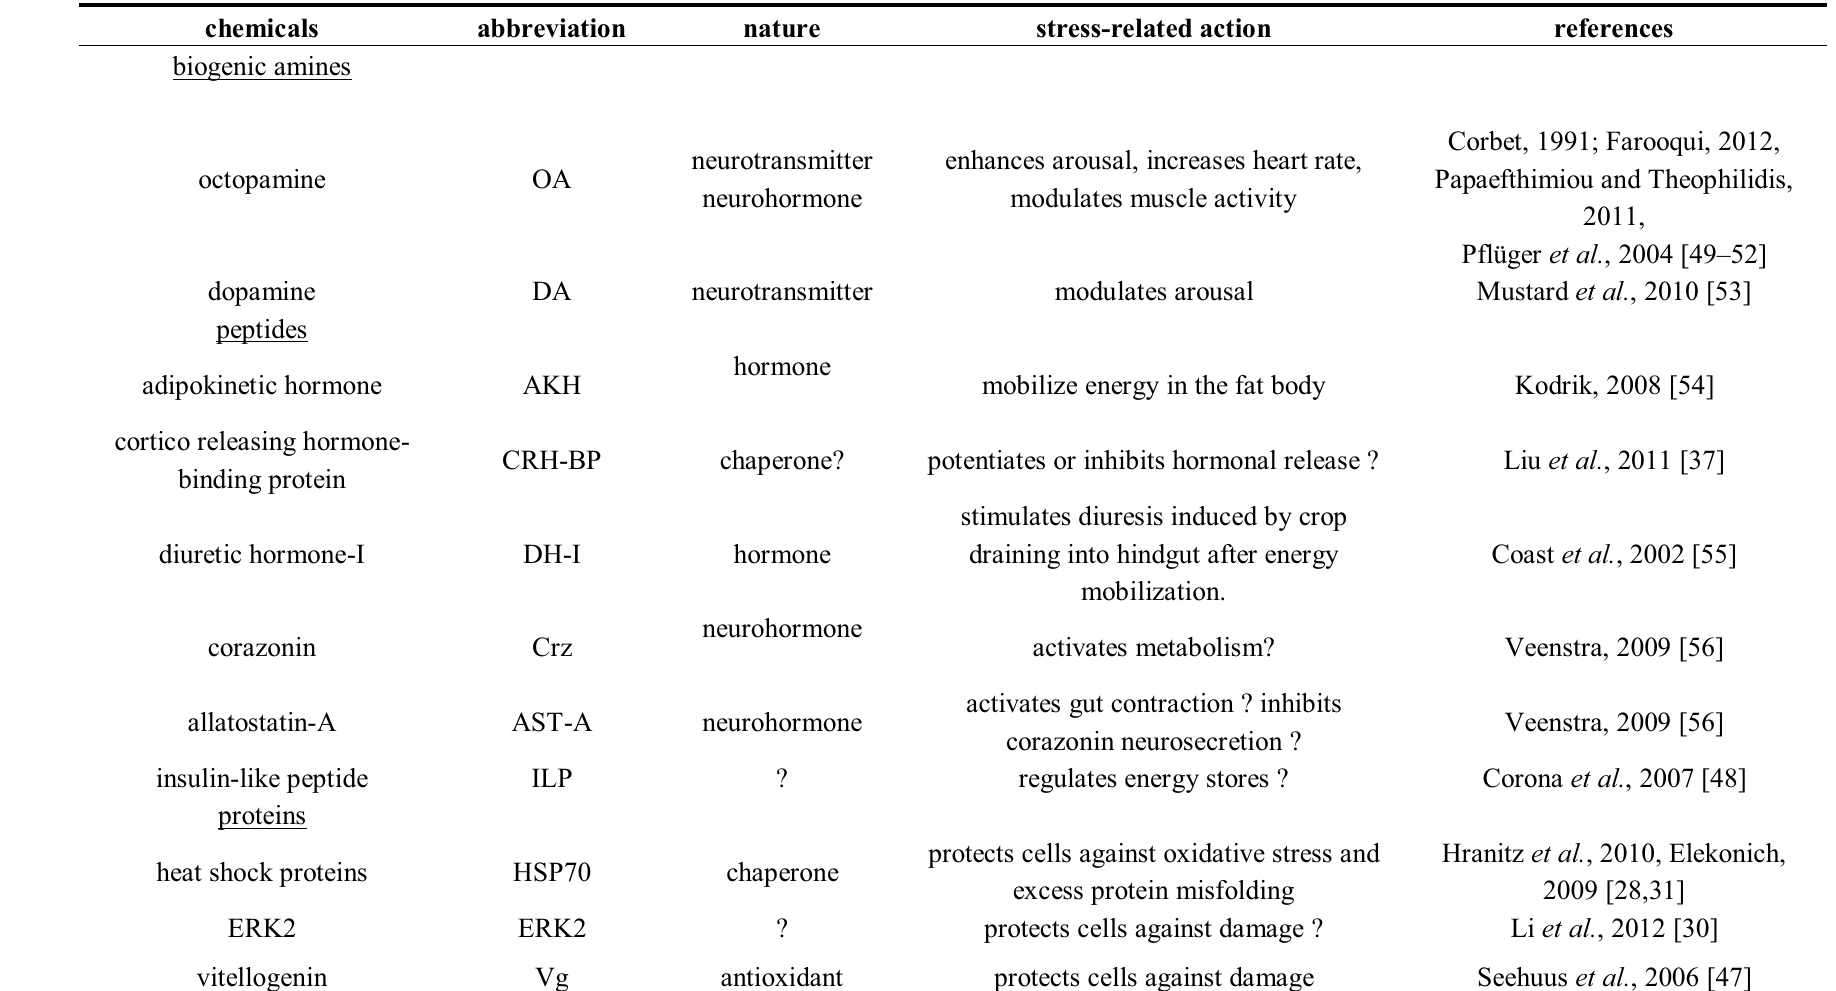
Table 2. Main elements of the general stress response in the honey bee. The table gives the physiological role(s), known or hypothesized (as indicated by a question mark) for each element, following a classification based on chemical